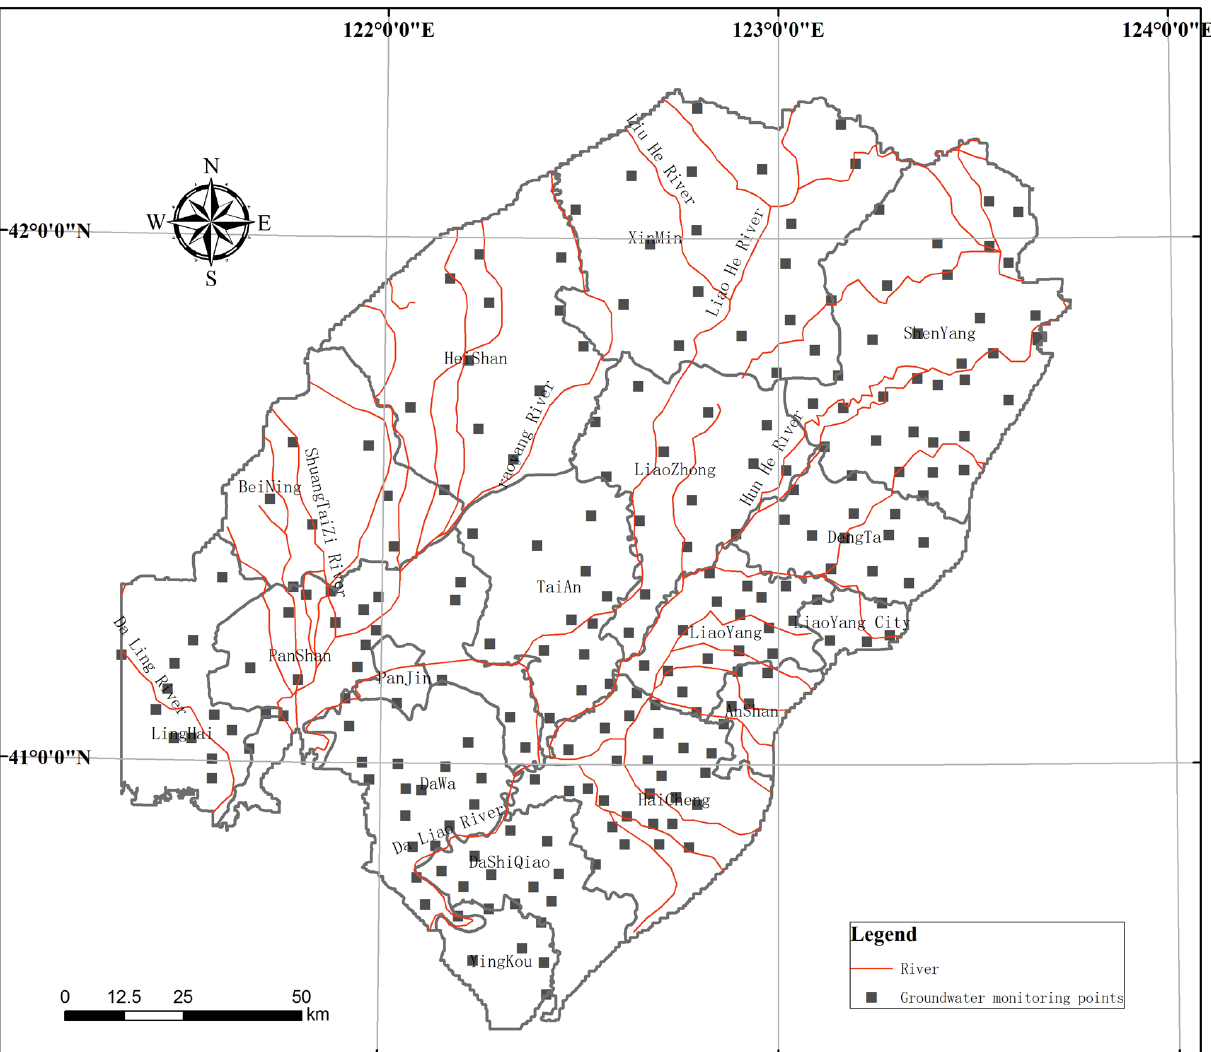
Fig 4. Location of groundwater monitoring